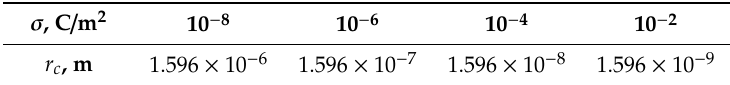
Table 3. The values of the critical distances between the electrodes calculated at various surface charge densities, at which the e ff ect of an increase in the force action of the electric field begins to be observed in comparison with the classical model of a flat capacitor. σ , C / m 2 10 − 8 10 − 6 10 − 4 10 − 2 r c , m 1.596 × 10 − 6 1.596 × 10 − 7 1.596 × 10 − 8 1.596 × 10 −